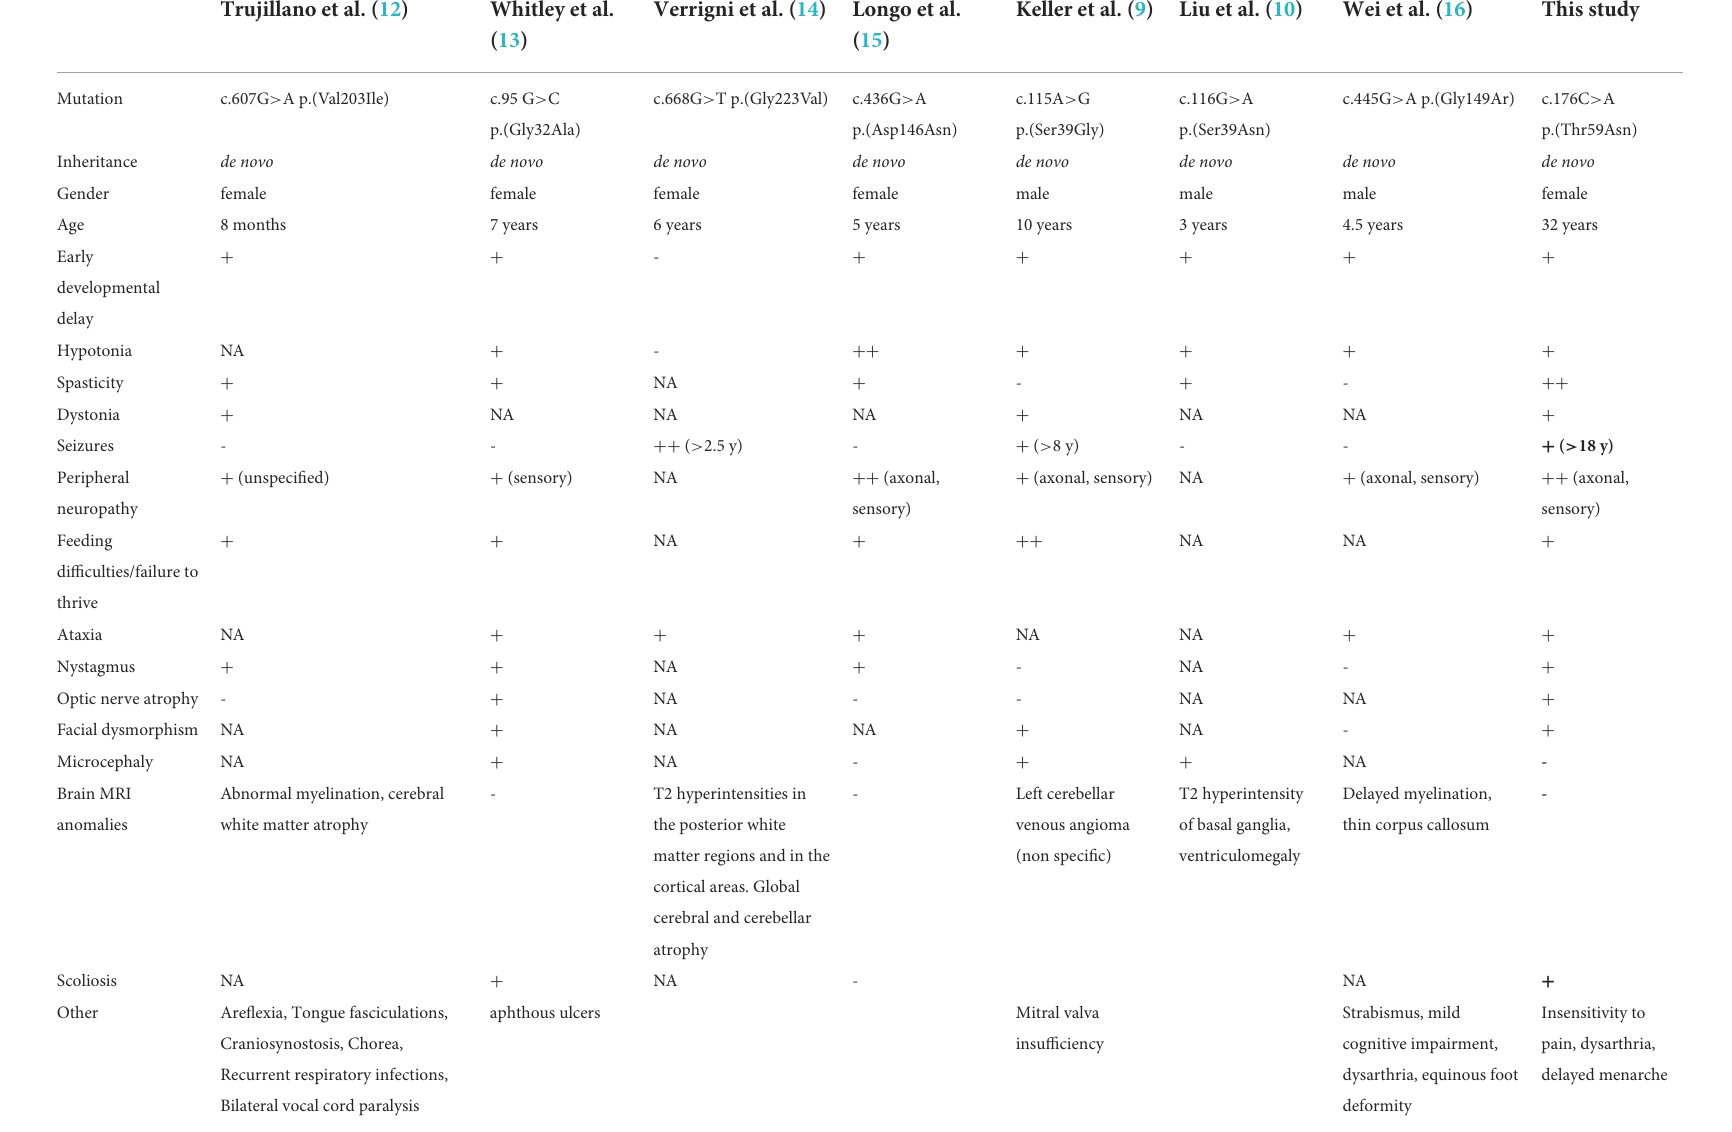
TABLE 1 Summary of the clinical and genetic features of the patient in this study compared with EMPF1 patients described with a de novo heterozygous mutation in the GTPase domain of